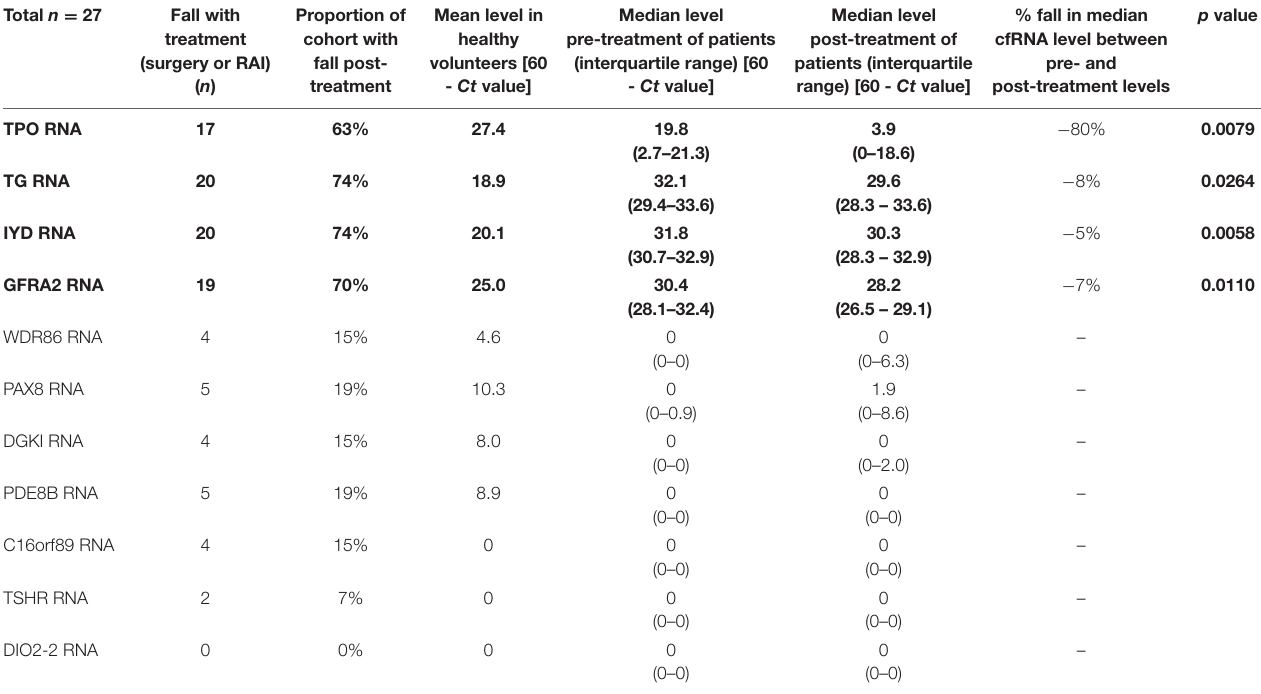
TABLE 2 | Circulating levels of thyroid-specific cfRNA transcript candidates pre- and post-treatment in patients undergoing thyroidectomy or adjuvant radioactive iodine therapy. Total n = 27 Fall with Proportion of Mean level in Median level treatment cohort with healthy pre-treatment of patients (surgery or RAI) fall post- volunteers [60 (interquartile range) [60 ( n ) treatment - Ct value] - Ct value]